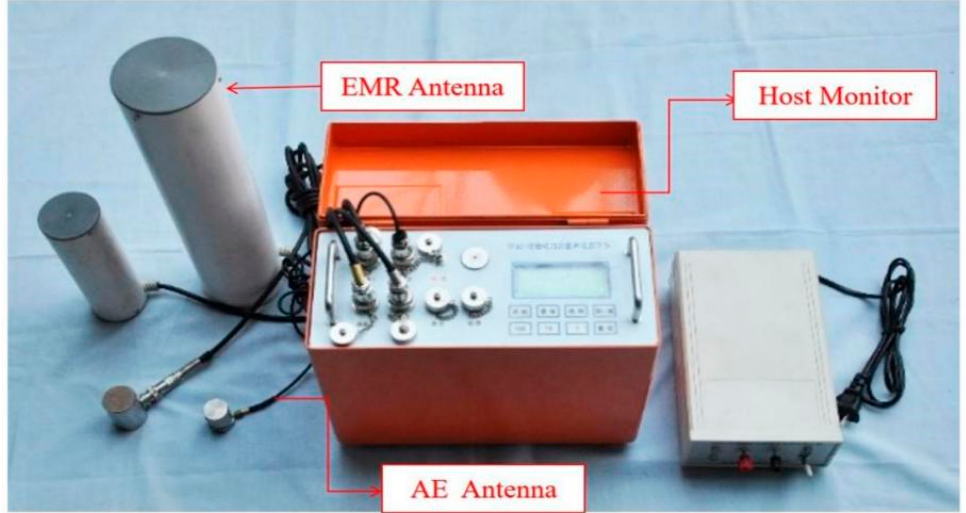
Figure 3. YDD16 acoustic-electromagnetic monitor.